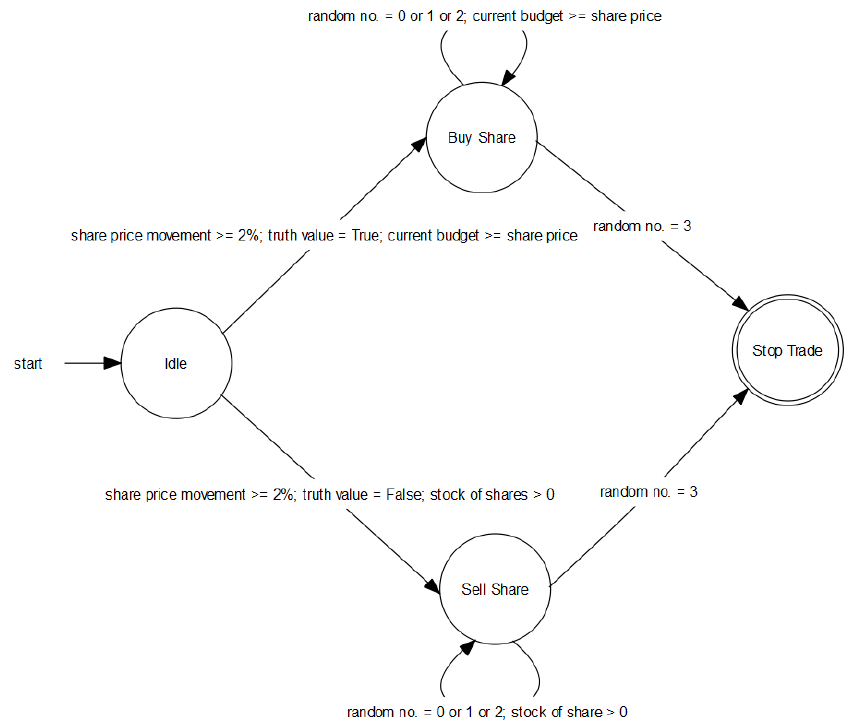
Fig. 3. Fifth evolution stage of the Non-Player Character Finite State